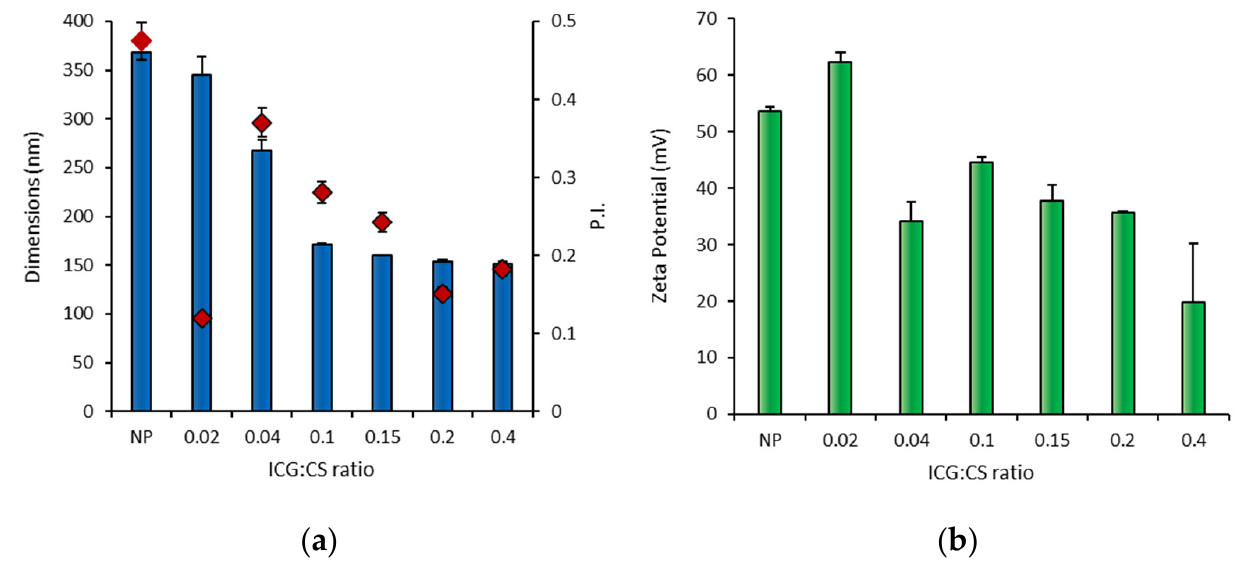
Figure 1. Dimensions, polydispersity index (PI red diamond symbols) ( a ) and zeta potential values ( b ) of unloaded NPs without ICG (NP) and after addition of increasing ICG up to an ICG:CS ratio of 0.4 (mean values n = 3 ± s.d.) .